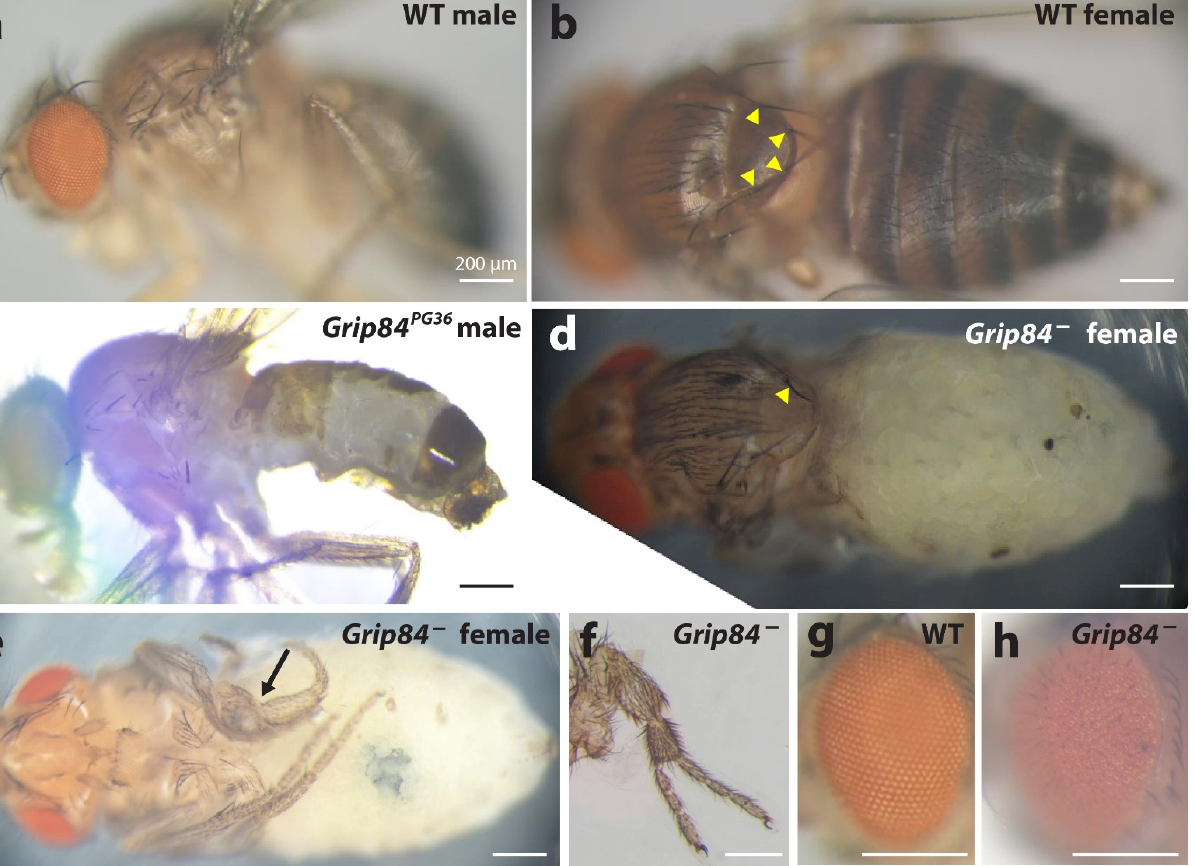
Figure 4. Phenotypes of the Grip84 mutants. ( a ) Wild type (WT) male sibling and ( b ) (WT) female sibling, lateral and dorsal views, respectively. ( c ) Grip84 PG36 hypomorphic male fly lacking vast re- gion of the normal cuticle on the abdomen. ( d ) Pharate adult female fly, Df(1)14.4 ; Dp(1;3)DC364; pulled out of the pupal case, shown from dorsal view and ( e ) ventral view. The abdominal pig- mented cuticle is completely absent. Yellow arrowheads point at the bases of four bristles on the notum in the WT female fly; ( b ) in the mutant female fly, ( d ) only one bristle is left. In the mutant female, one of the legs is incorrectly developed (( e ) arrow); in some cases partial leg duplications were observed for the same genotype ( f ). A wild type eye from panel a is magnified in ( g ), showing the characteristic, hexagonal structure, which is absent in Df(1)14.4 ; Dp(1;3)DC364 flies ( h ). The transgenic fly construct (see Section 2) completely rescues viability and other Grip84 phenotypes. However, Drosophila has another, less conserved homologue, cg7716 (27/46 identity/similarity). To assess the effect of full depletion of TUBGCP2 activity in the fly, we therefore created a double mutant knock out (KO) fly stock, knocking out expres- sion of both TUBGCP2 fly homologs, Grip84 and cg7716 (see Section 2 and Supplementary Figure S1). The cg7716 mutation is viable and fertile. We found Grip84 / cg7716 KO larvae pupate at day 6, a day later than wild type (WT) siblings (day 5). Mutant larval brains at day 5 and 6 (Figure 5a,b) are markedly smaller than WT brains at day 5 (Figure 5c,d) and seem to be structurally abnormal.